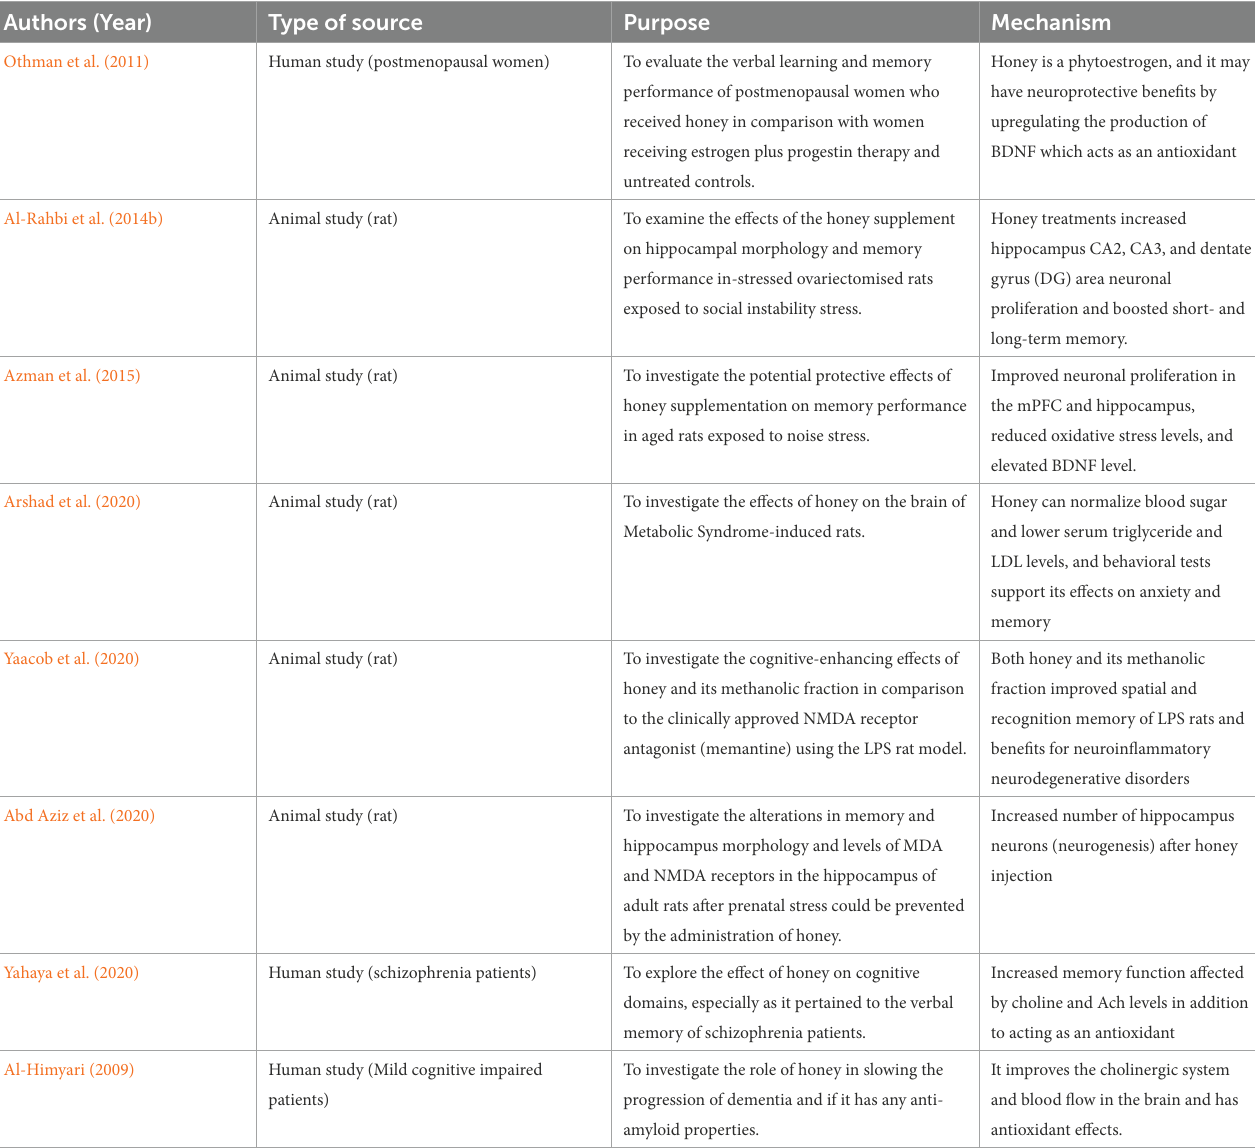
TABLE 2 Memory booster effects of honey supplementation on human and animal